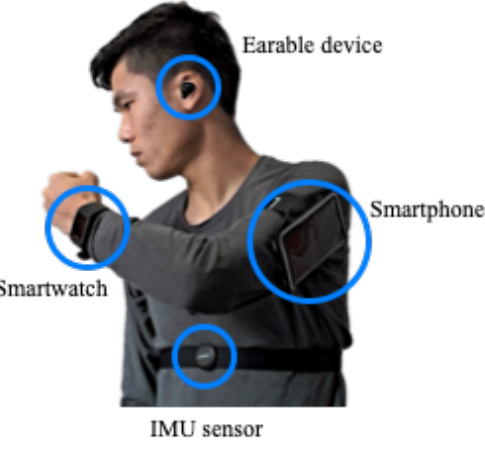
Figure 6. Sensors used for the experiment and their